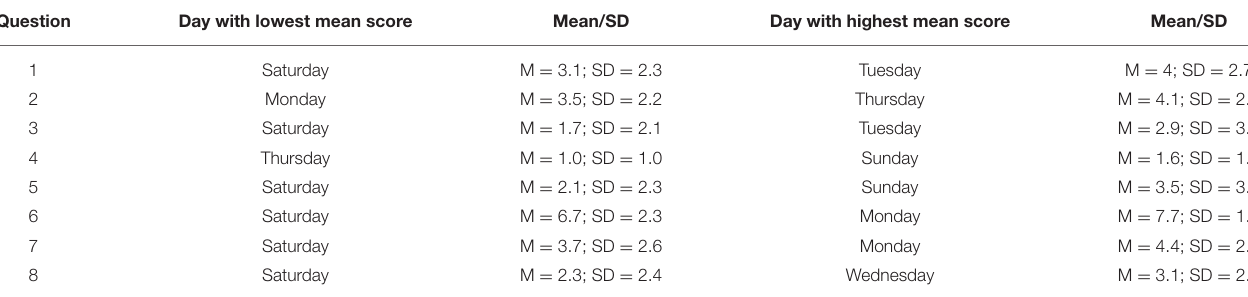
TABLE 4 | Highest and lowest mean scores for the daily questions, by weekday. Question Day with lowest mean